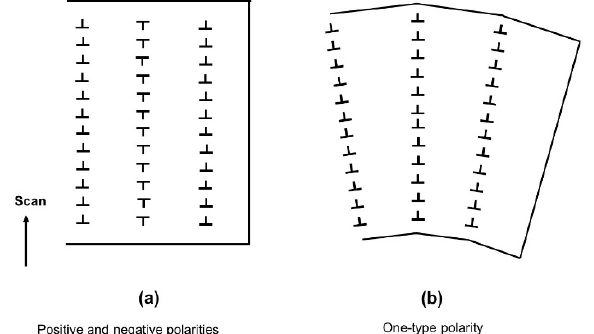
Figure 5. Schematic view of the tilt boundaries described by edge dislocation arrays. ( a ) configuration of tilt boundaries to keep the same in-grain crystal orientations. ( b ) configuration of tilt boundaries with the dislocations with the same polarities resulting in the bending of the in-grain crystal orientations.